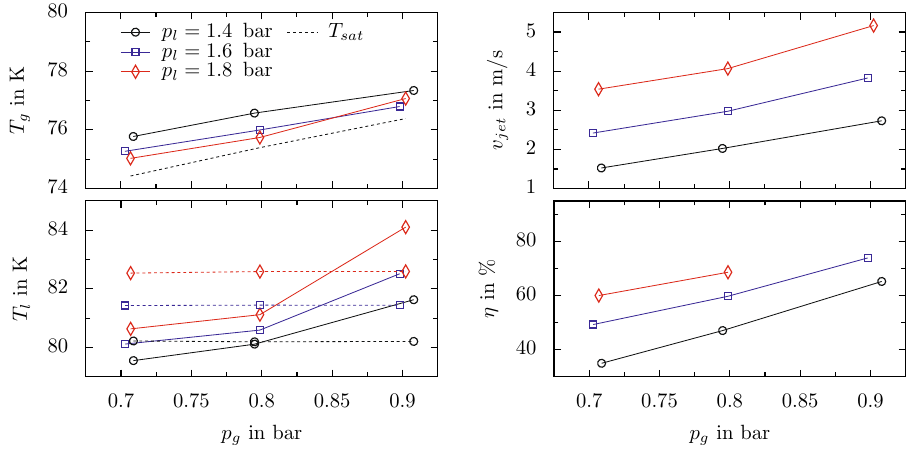
Figure 6. Effect of varying operation pressures p g and p l on the resulting temperatures T g and T l , the jet velocity v jet and the device efficiency η . Dashed lines in the graphs for temperature represent the saturation temperature for the respective pressures. In the graph for T g , the saturation temperature refers to p g , while it corresponds to p l in the graph for T l